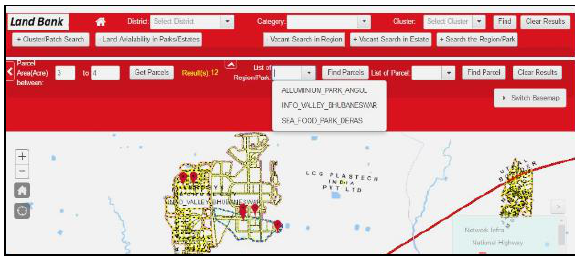
Figure 8. "Vacant Search in Estates/Region" contains options to Search Vacant